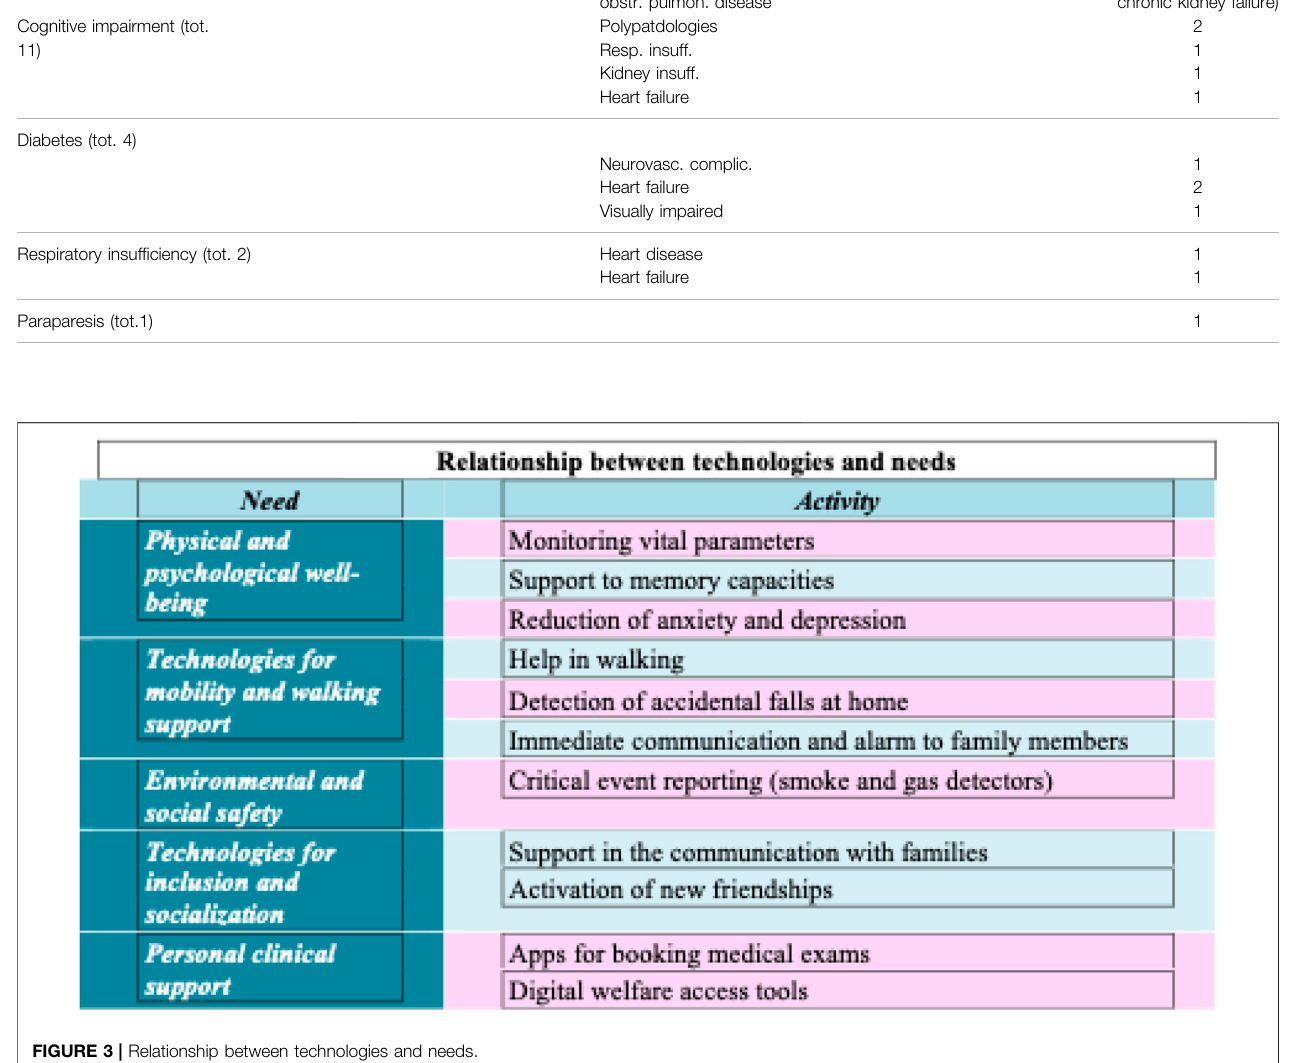
Cognitive impairment (tot. 11)